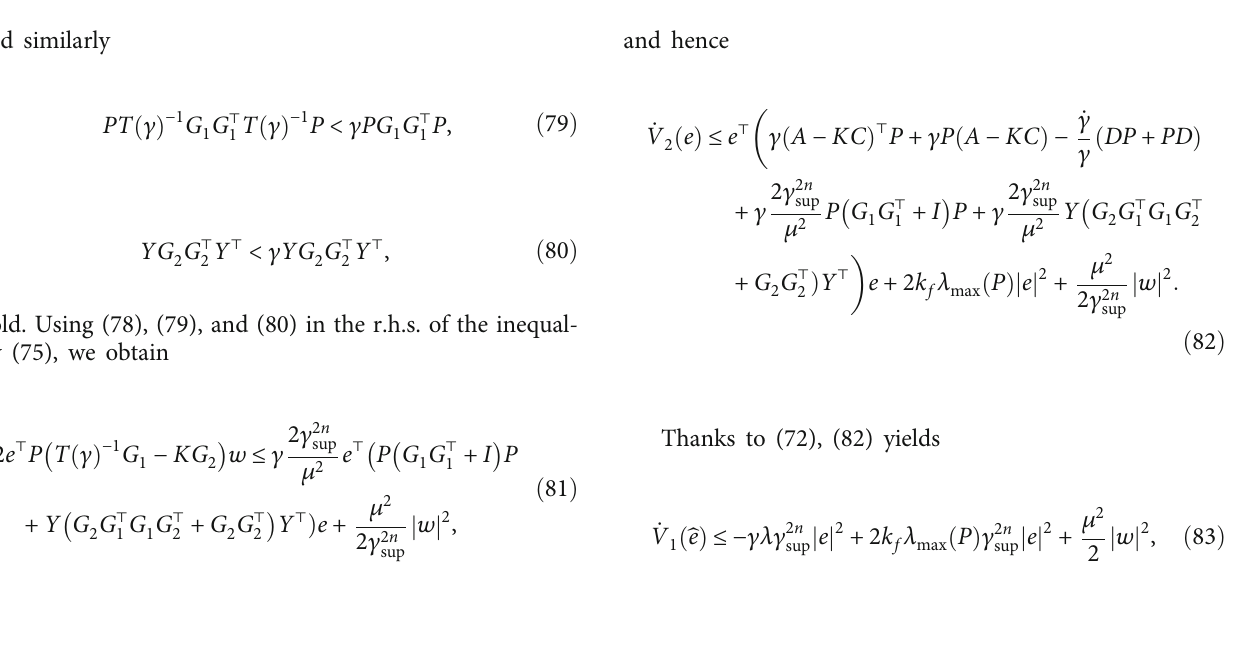
Figure 1: Measurement, state variables, estimates, residuals, and γ ð t Þ in the transient for x ð 0 Þ = ð 0,0,0 : 01 Þ and ̂ x ð 0 Þ = ð 1, 1, 1 Þ in a noise-free